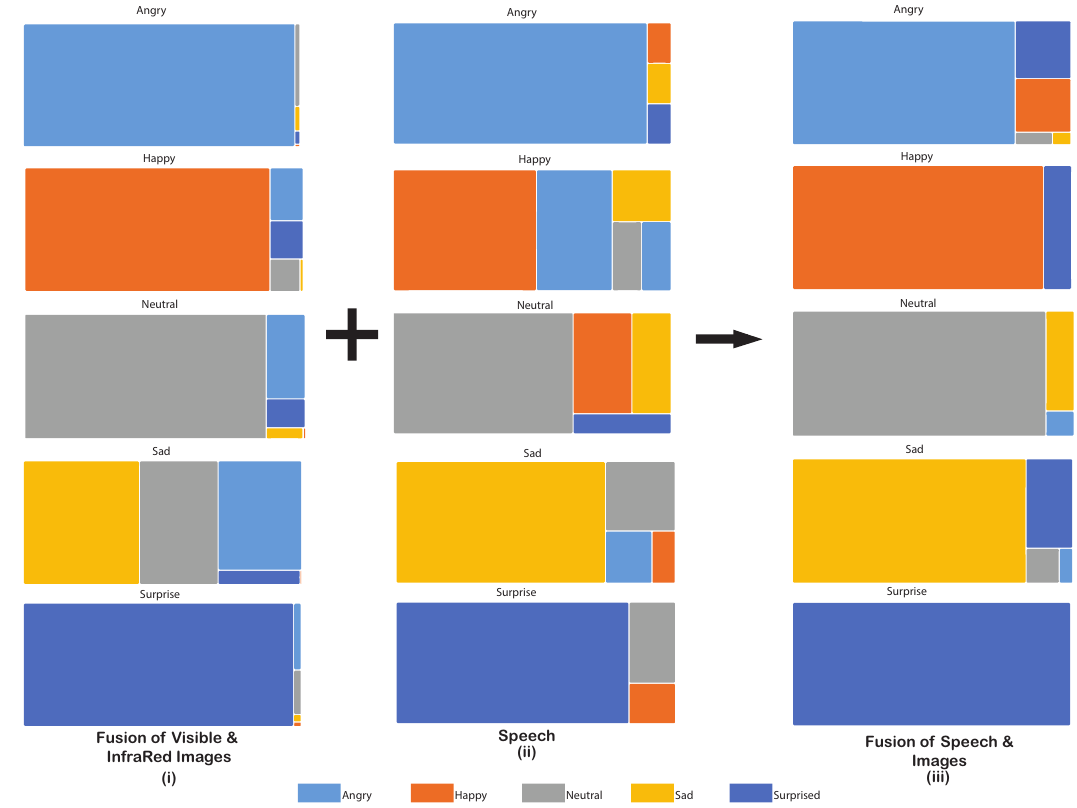
Figure 9. Treemap displaying the proportional accuracy for every detected emotion in the images, the speech, and the fusion of the images and